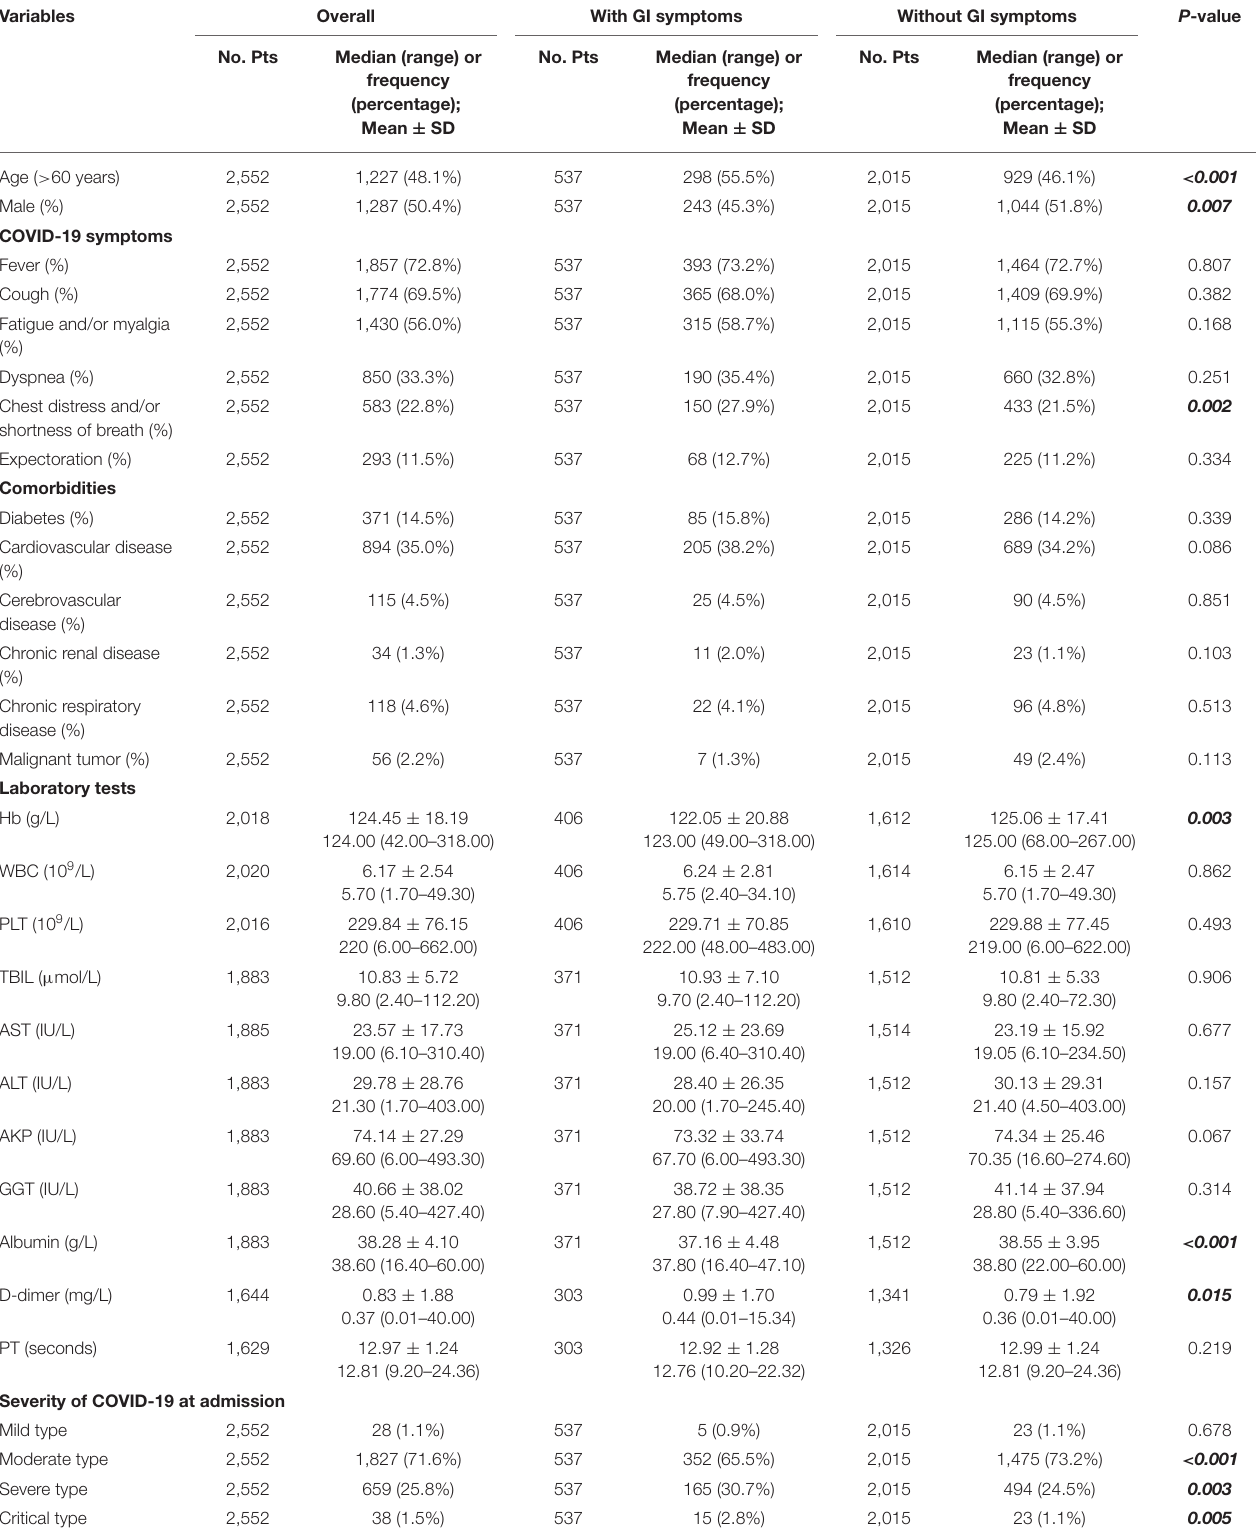
TABLE 1 | Characteristics of COVID-19 patients with and without GI symptoms. Variables Overall With GI symptoms Without GI symptoms P